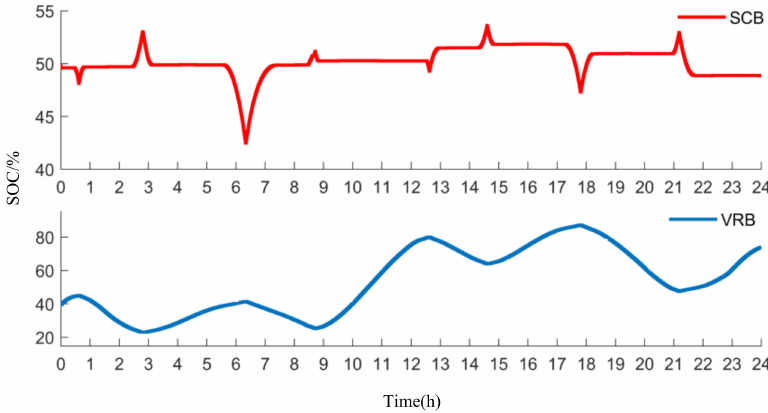
Figure 18. SOC of VRB and SCB over 24 h based on rule-based control